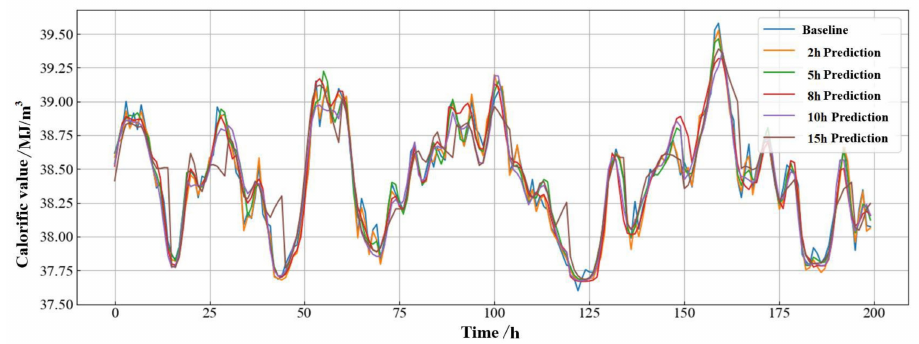
Figure 12. Prediction results of calorific value under different time scales.